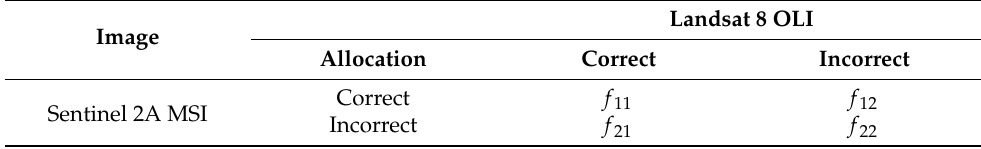
Table 4. Statistical significance parameters for two classifications using McNemar’s